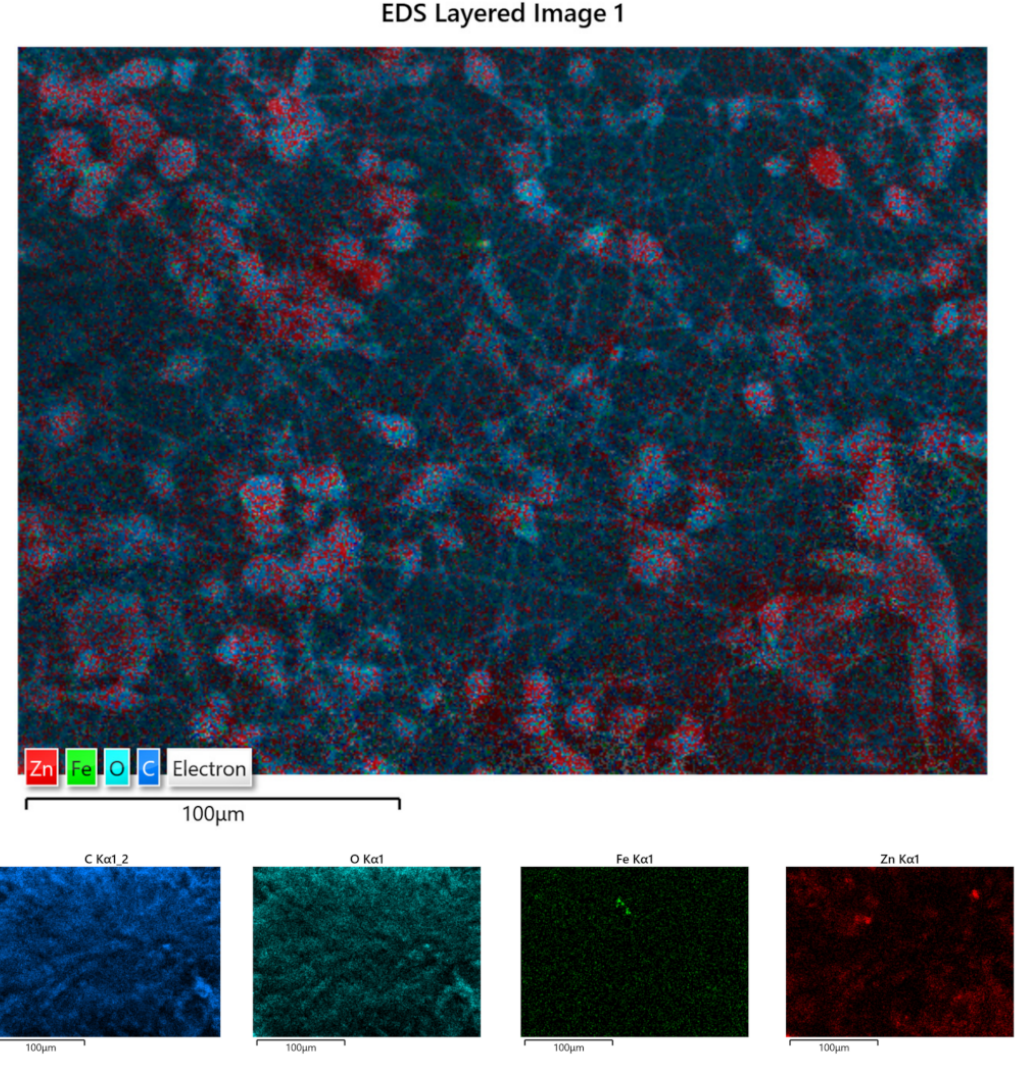
Figure 5. EDS mapping of